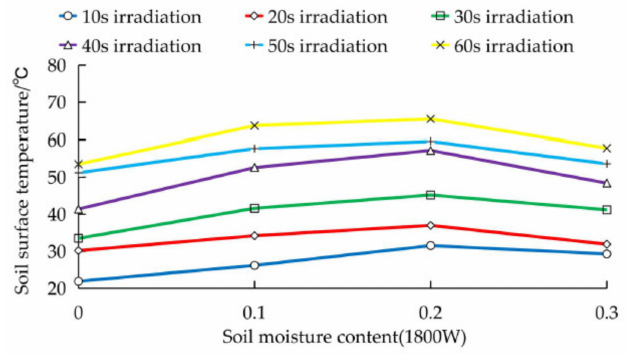
Figure 17. Change in soil moisture content and soil surface temperature (1800